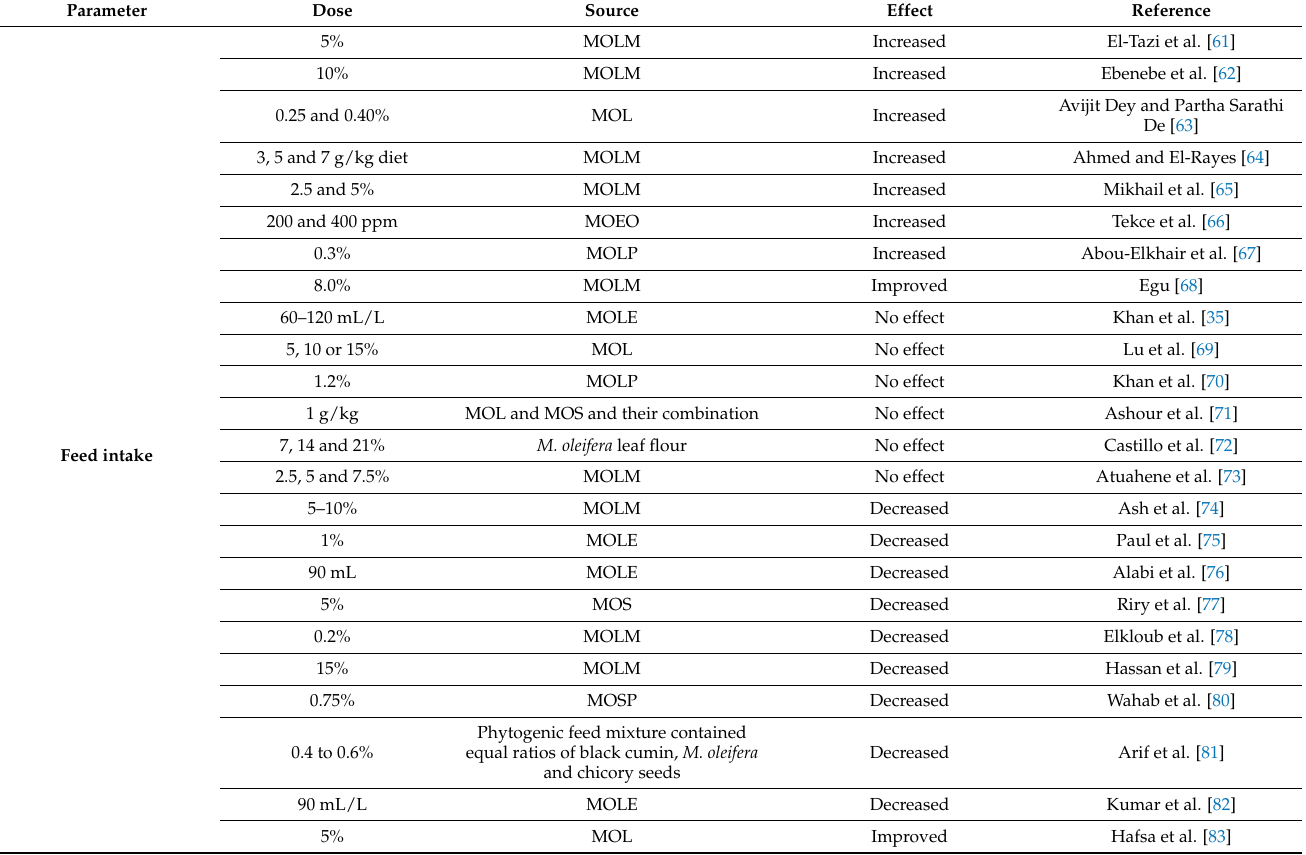
Table 2. Effects of M. oleifera on different parameters of